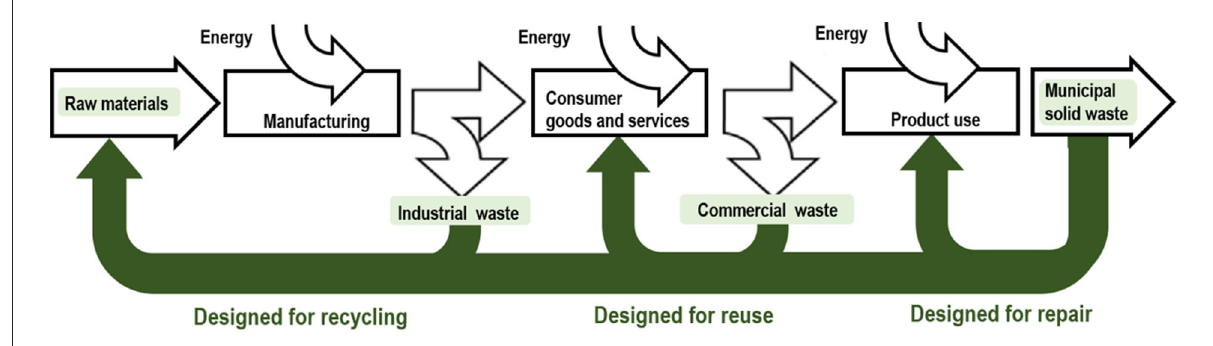
FIGURE4 Closing the loop, as a way of reusing products and recovering materials that are destined for